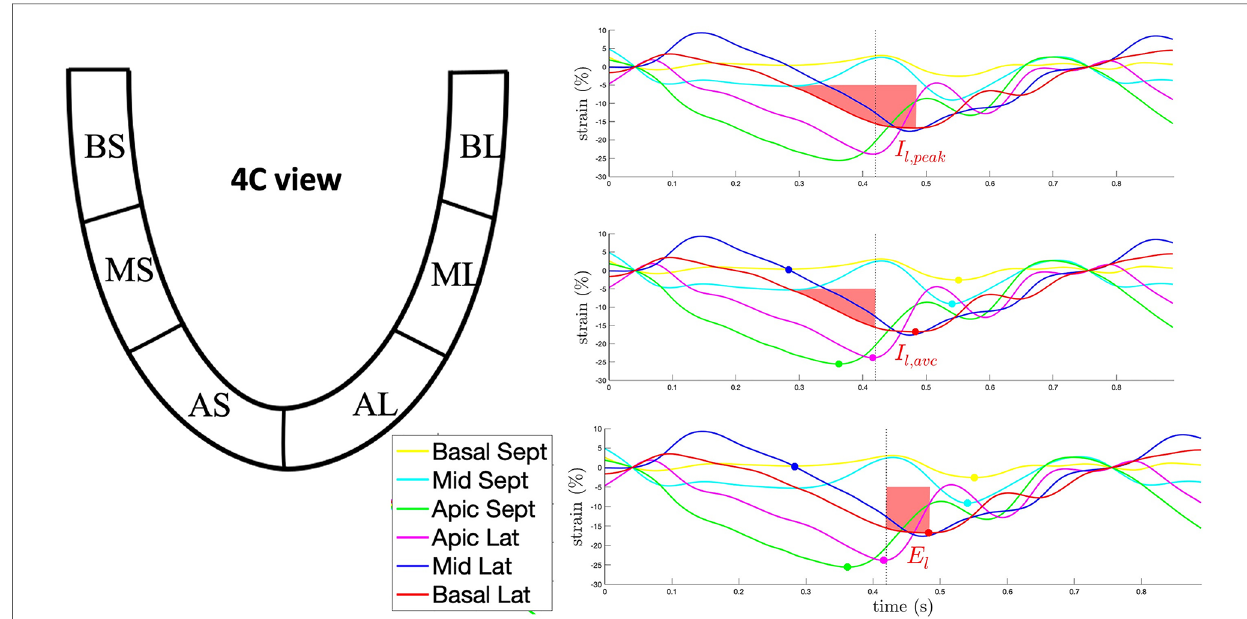
FIGURE 2 Example of the semi-quantitative analysis of the strain curve dynamics through the calculation of strain integrals for the basolateral segment in 4- chamber view. Upper panel: the red-shaded area represents the integral to strain peak (I l,peak ). Middle panel: the red-shaded area represents the integral to aortic valve closure (I l,AVC ). Lower panel: the red-shaded area represents E l , the difference between I l,peak and I l,AVC , corresponding to the waste energy due to the delayed lateral wall contraction. AL, apico-lateral segment; AS, apico-septal segment; BL, basal-lateral segment; BS, basal- septal segment; ML, mid-lateral segment; MS, mid-septal segment.